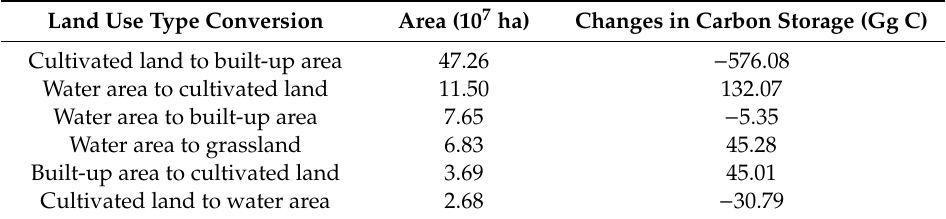
Table 10. The e ff ects of the conversion of the main land-use types on carbon storage during 2010-2018. Land Use Type